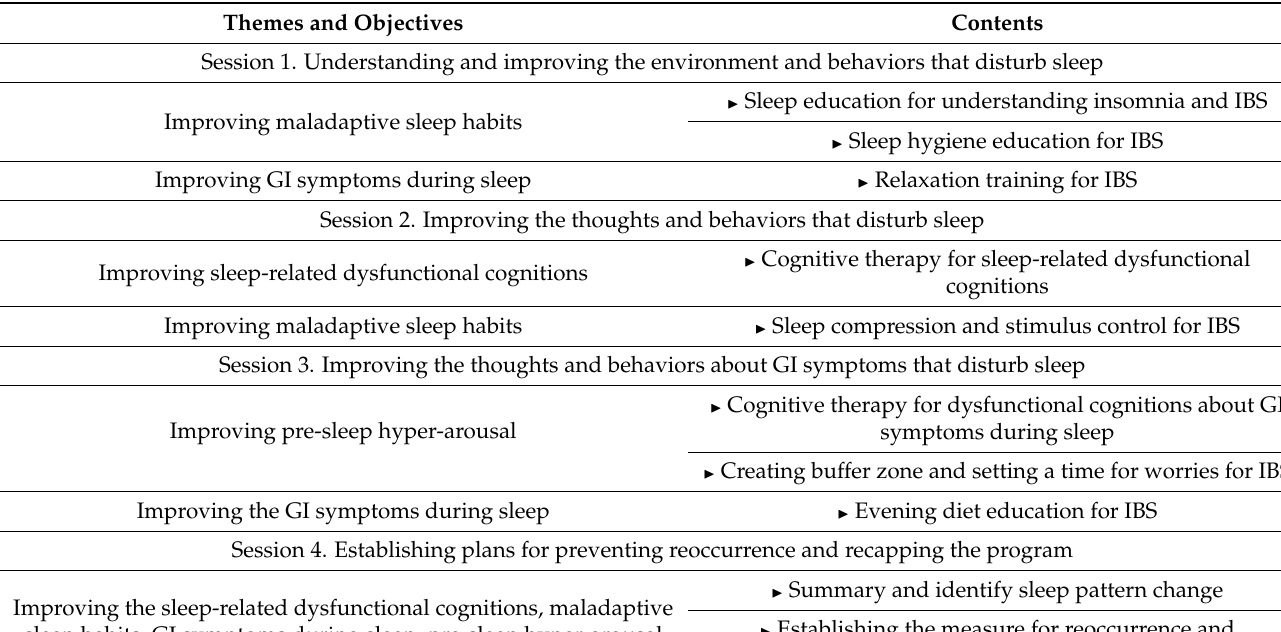
Table 1. Details of the Cognitive Behavioral Therapy for Insomnia (CBT-I) for IBS subjects with